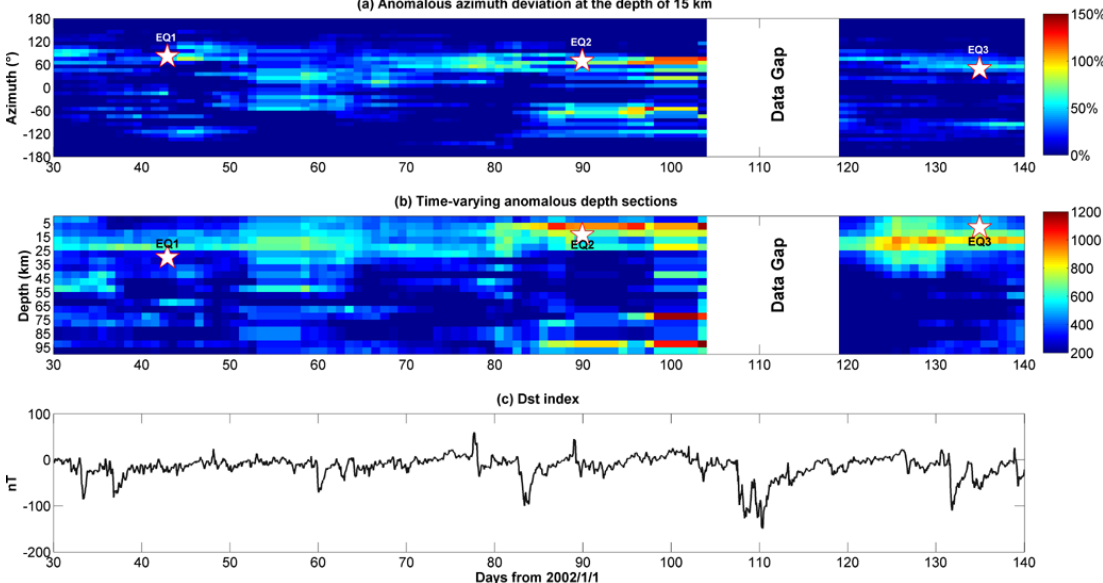
Fig. 4. The anomalous azimuth deviations at 15km deep (a) , time-varying anomalous depth sections (b) and Dst index (c) during EQ2. Open stars denote the earthquake azimuths and the hypocentre depths of EQ1, EQ2 and EQ3.